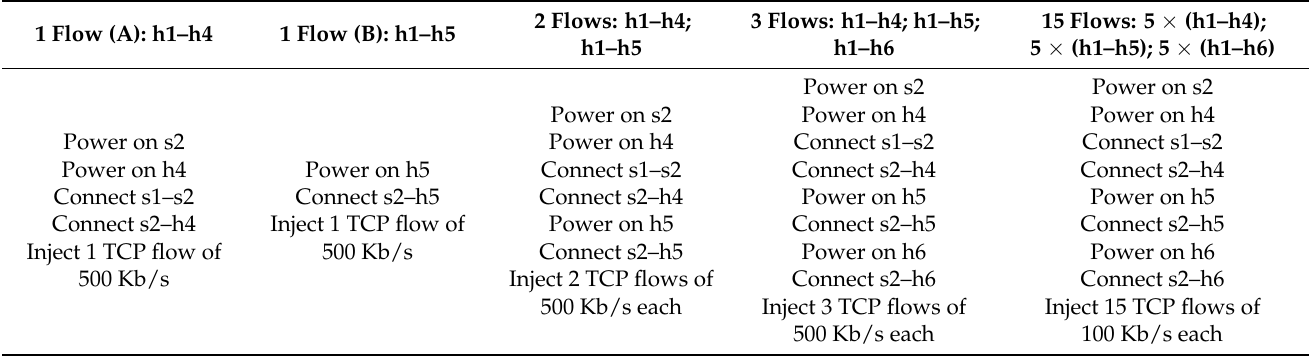
Table 4. Stress functional tests.